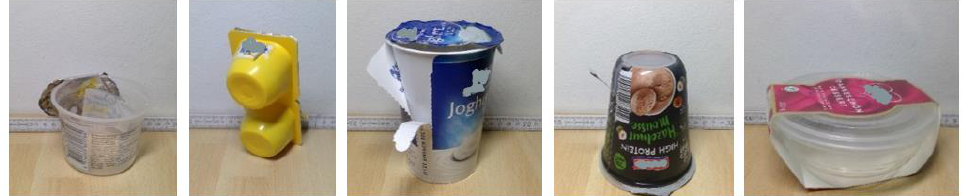
Figure 1. From left to right: cup directly printed, cup with paper label, cup with printed carton sleeve, cup with shrink sleeve, cup with sleeve.